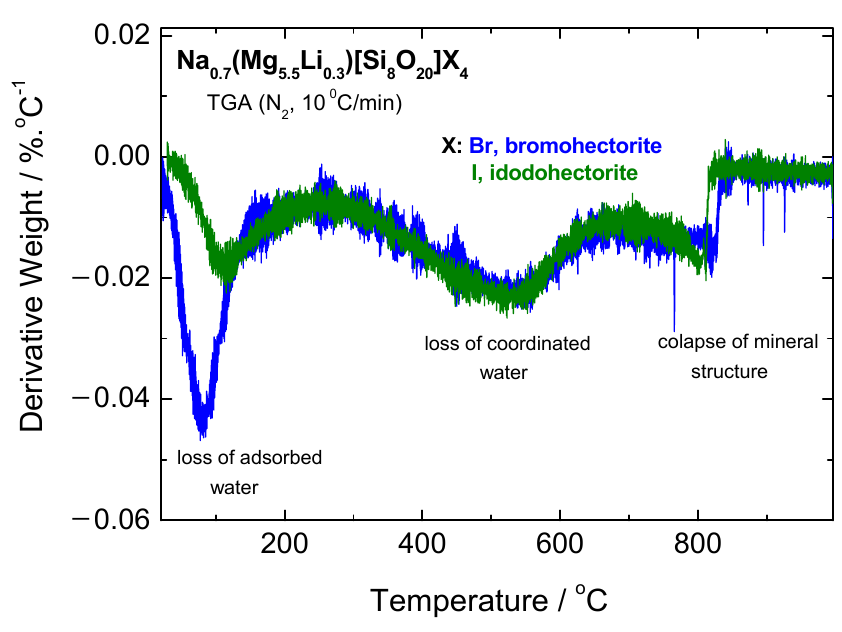
Figure A1. The first derivative of the TGA curves of bromohectorite and iodohectorite.